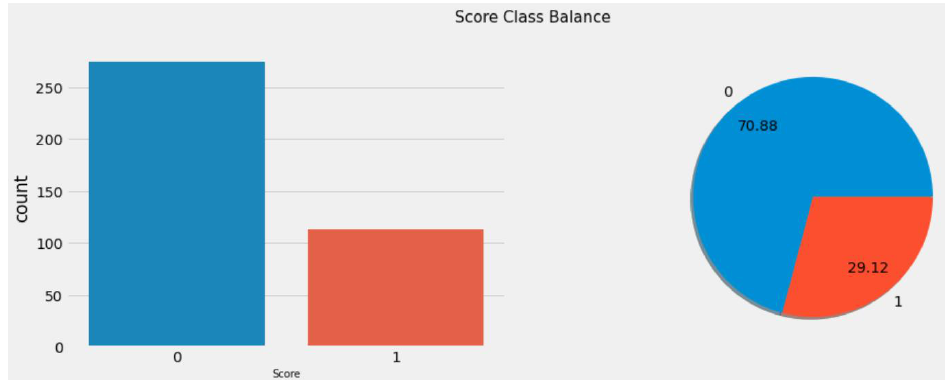
Figure 6. Distribution of the binary target class.